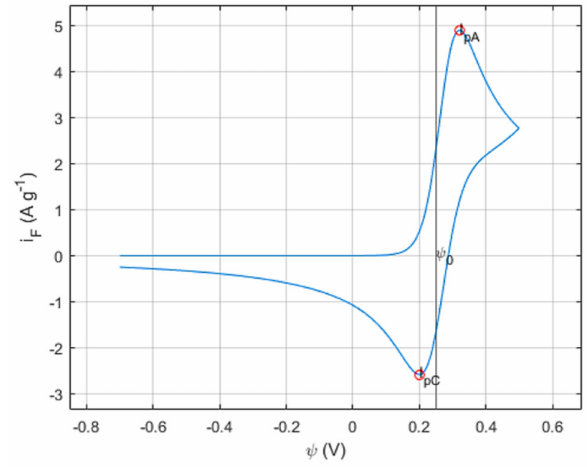
Figure 3. Cobalt hydroxide nanofoam-simulated